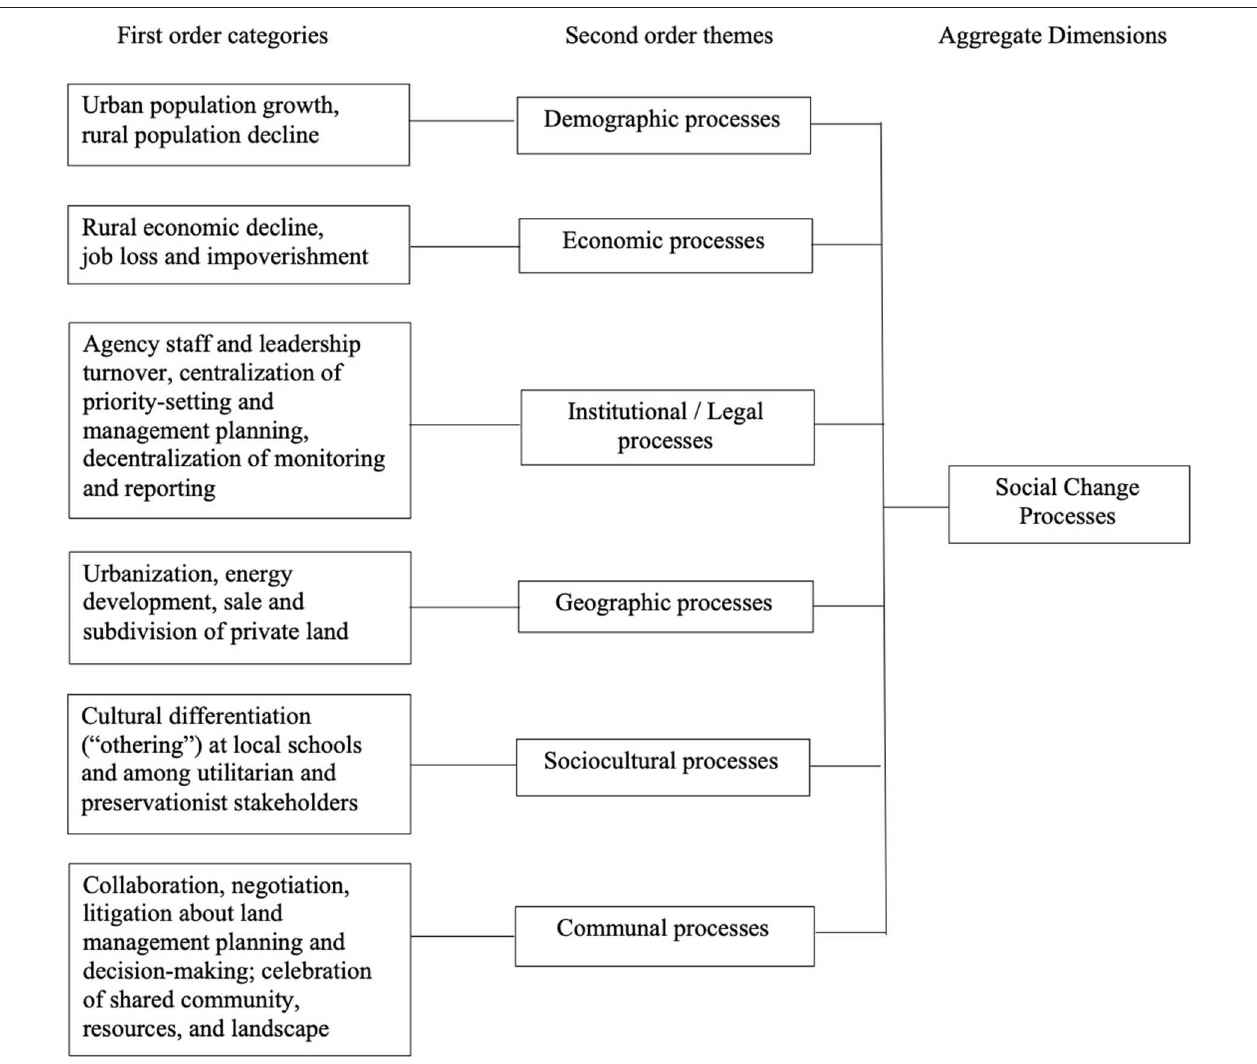
FIGURE 3 | Data structure formed by iterative analysis to identify social change processes.